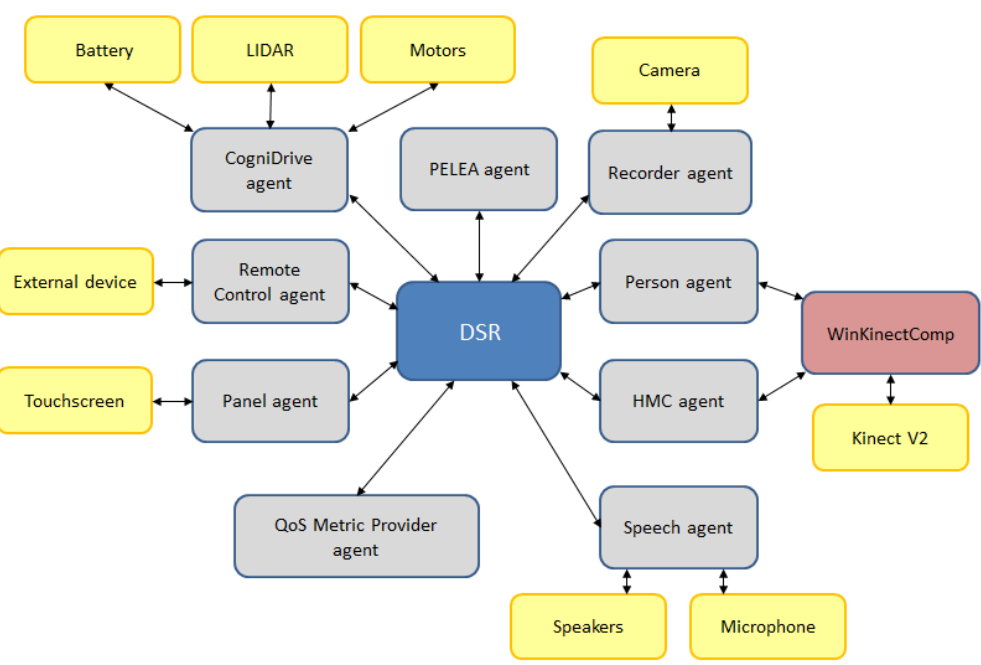
Figure 5. Overview of the software architecture within the CLARC